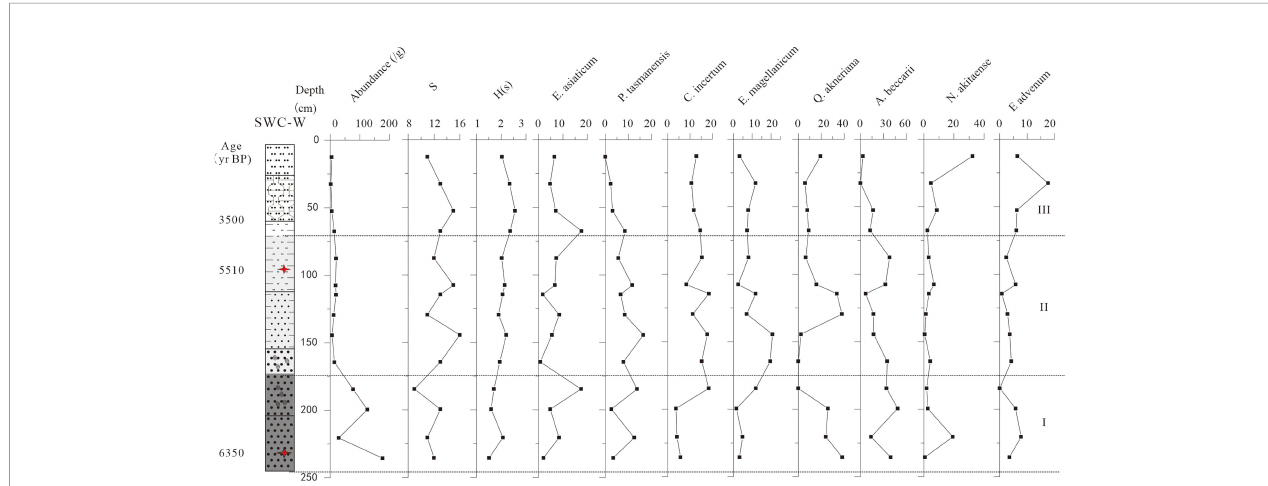
FIGURE 4 | Curves of foraminifera indices and percentage of some typical taxa in SWC-W pro fi